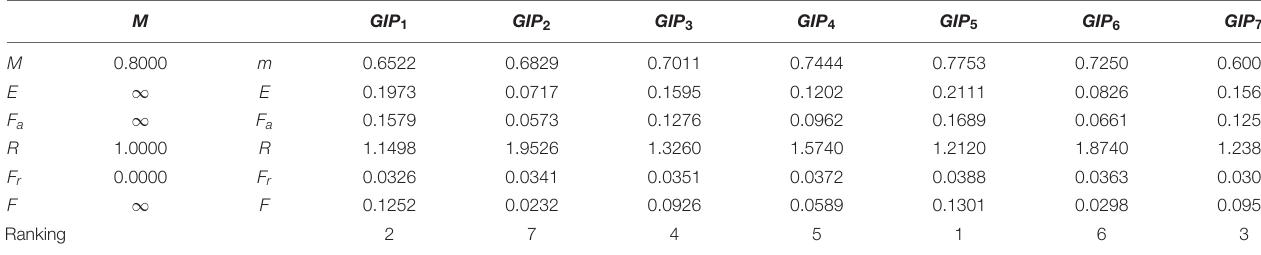
TABLE 12 | The niche mass, field strength, attraction, radius, and